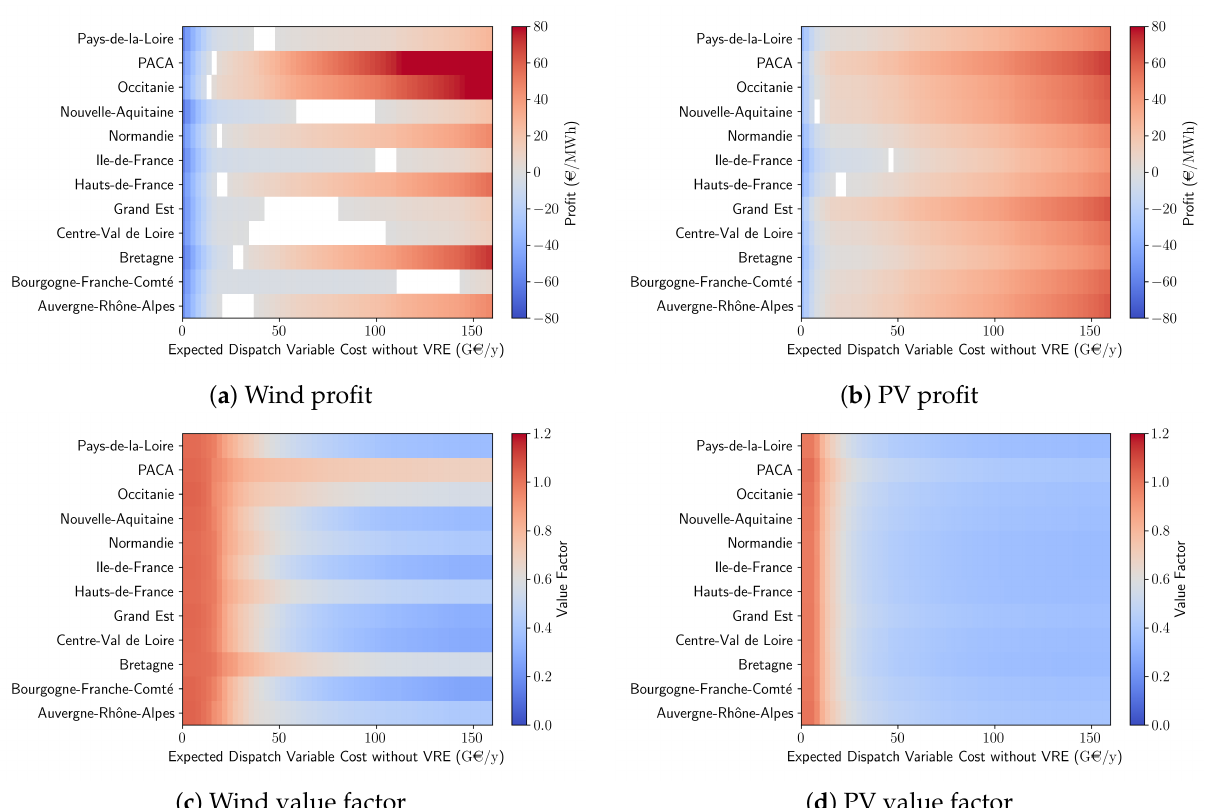
Figure 8. Regional distributions of ( top ) potential profits (Equation (6)) and ( bottom ) value factors (Equation (7)) of wind ( left ) and photovoltaic ( right ) for the optimal solution of the variable problem. Low absolute values of the profits are in gray, but values that are exactly zero (up to numerical accuracy) are in